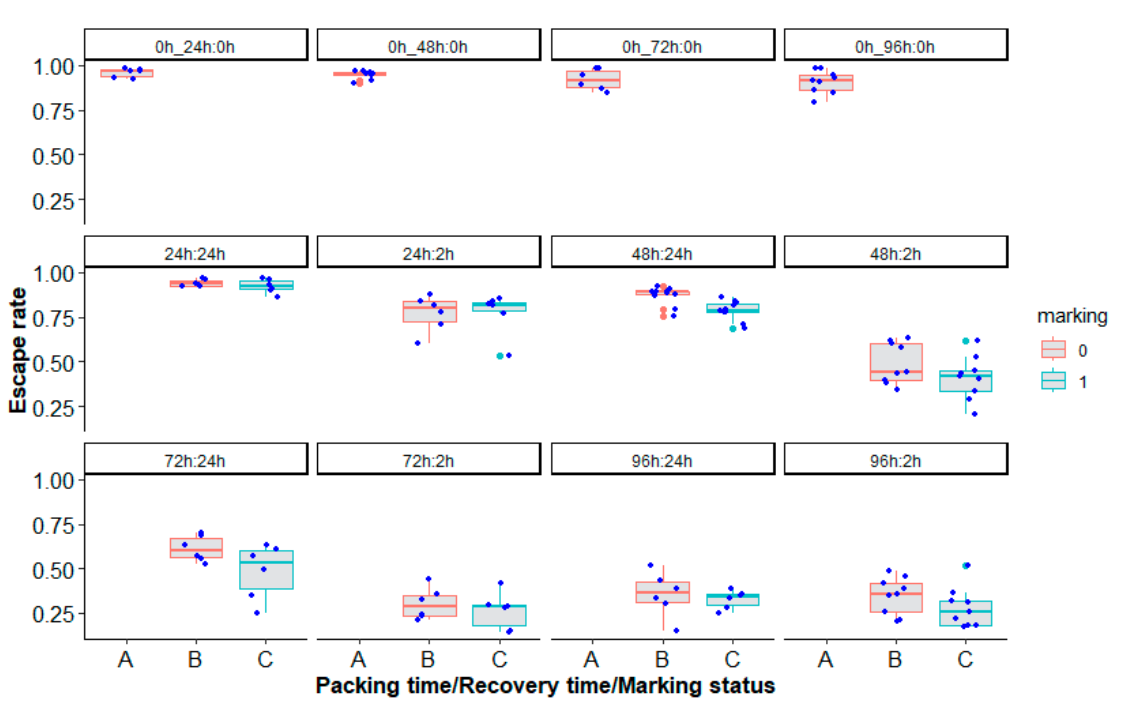
Figure 7. Escape rates according to the marking status (A = control, B or 0 = unmarked, C or 1 = marked), packing duration (0 h, 24 h, 48 h, 72 h and 96 h) and the time after unpacking (0 h, 2 h and 24 h recovery times) of Aedes aegypti , Brazil strain, in laboratory conditions. Control groups were assessed daily for packing time and were labeled as 0 h_24 h:0 h, 0 h_48 h:0 h, 0 h_72 h:0 h or 0 h_96 h:0 h panels. Blue and red bars indicate the median. The upper and lower limits of each box indicate the interquartile range. Each blue dot represents a value of the observed escape rate per replicate. Green and red dots represent outliers.